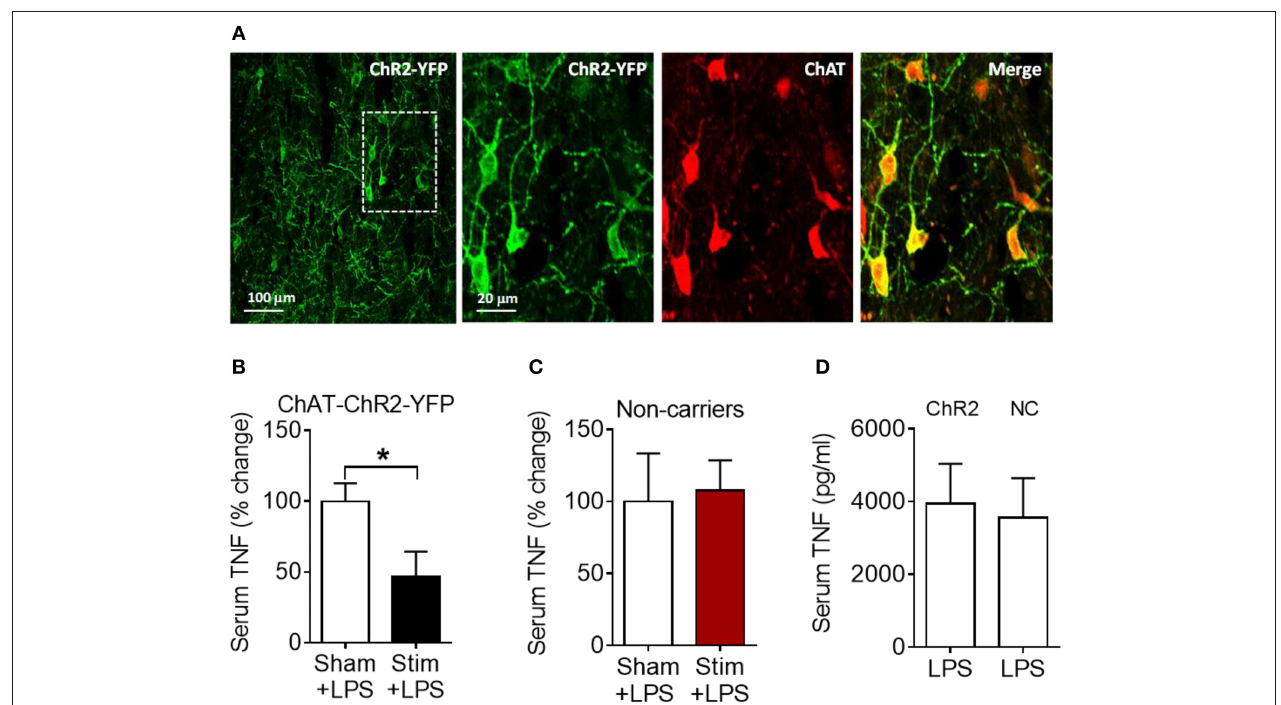
FIGURE 5 | Optogenetic stimulation of basal forebrain cholinergic neurons in the medial septum suppresses serum TNF in endotoxemic mice. (A) Immunostaining of medial septum neurons in a brain section of a ChAT-ChR2-EYFP mouse: EYFP immunostaining (first and second panel); ChAT immunostaining of the same area (third panel); and double immunostaining (fourth panel). (B) Optogenetic stimulation suppresses serum TNF during endotoxemia (* P = 0.039, unpaired two-tailed Student’s t test), n = 5–6 per group. (C) Laser light exposure of medial septum neurons in control (non-carrier) mice does not significantly alter serum TNF levels during endotoxemia (unpaired two-tailed Student’s t test), n = 6–7 per group. (D) LPS (i.p.) administration to ChAT-ChR2-EYFP (ChR2) and control (non-carrier, NC) mice does not result in statistically different serum TNF levels, (unpaired two-tailed Student’s t test), n = 9 per group. See Methods for